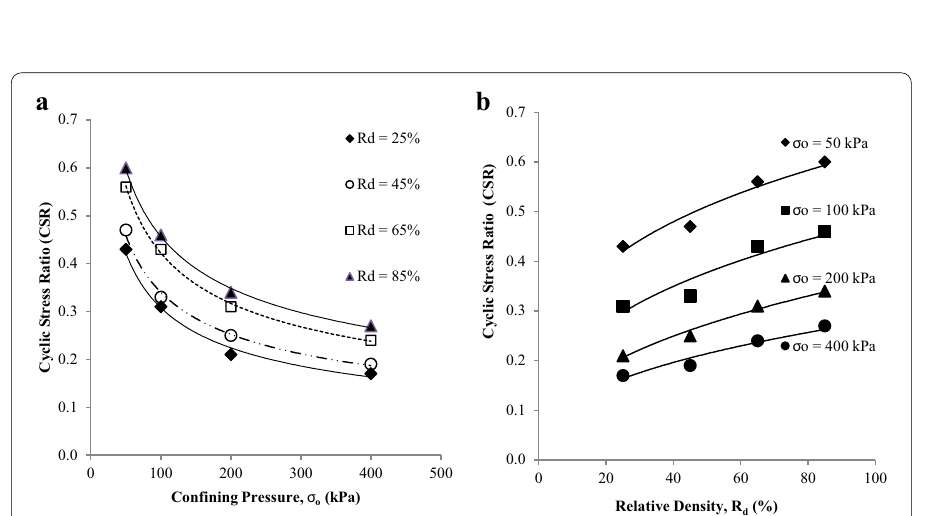
Fig. 15 Effect of a confining pressure and b relative density on the cyclic resistance (CSR) of sand for no. of cycles for initial liquefaction, N L =